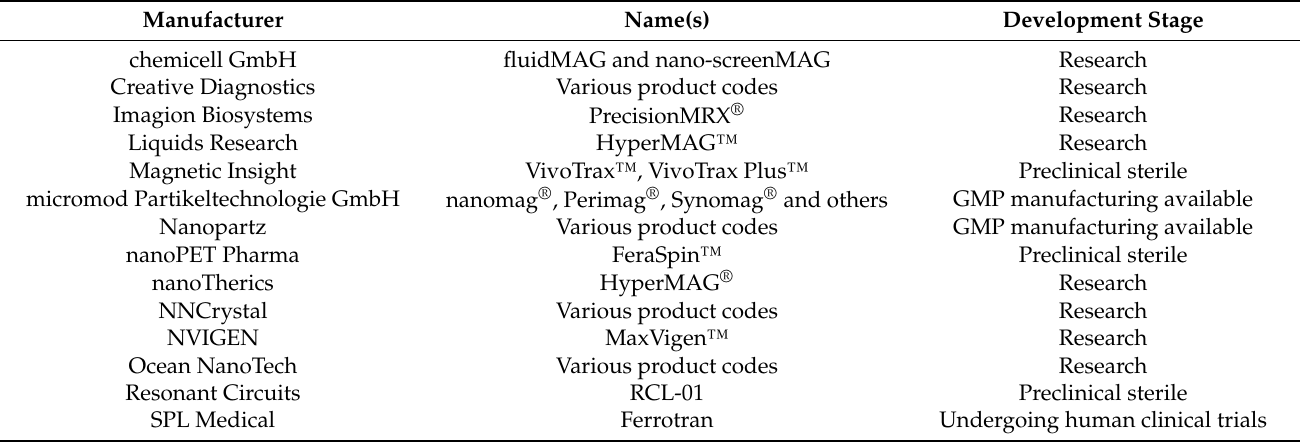
Table 3. Selection of commercially available research-grade